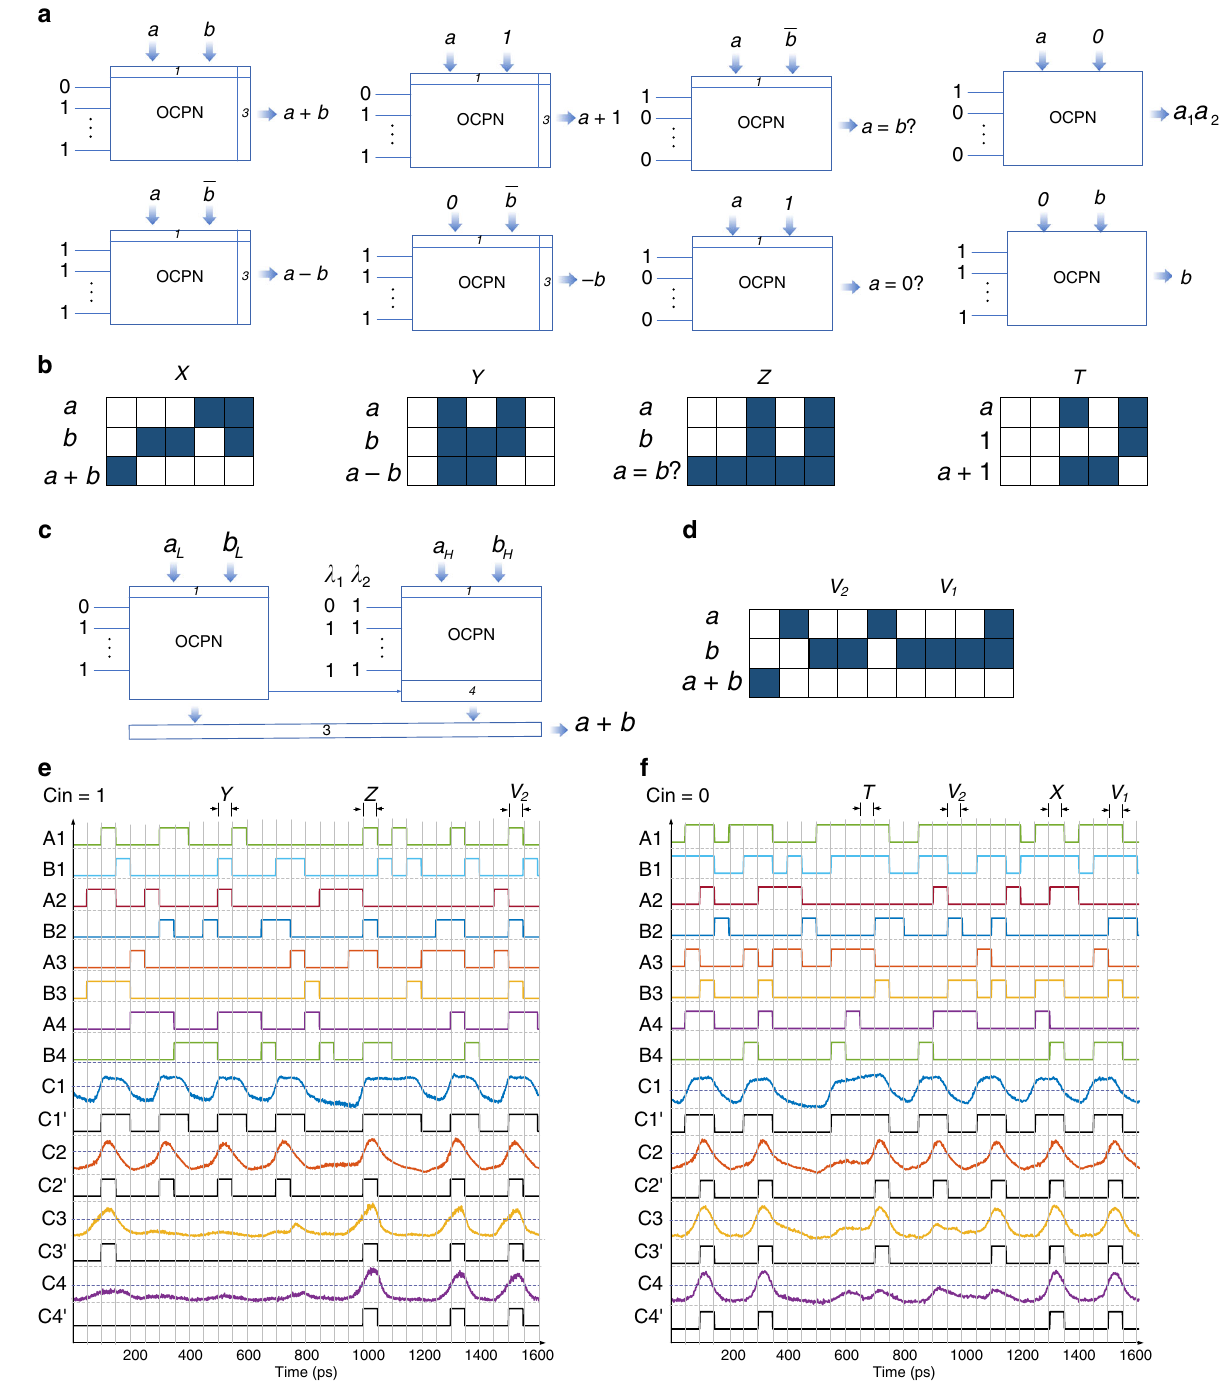
Fig. 3 Experimental results. a The functions that the proposed EPALU can achieve, including addition, subtraction, increment, decrement, compare and bit operation at different input combinations. Cell 1 represents the PGU. Cell 3 represents the SGU. b The testing result of the function realizations by the EPALU. The fi rst two rows are the inputs and the third row is the result. The blue cell means logic 1 and the white cell represents logic 0. The X, Y, Z, T correspond to the time slots in ( e ) and ( f ). c Assisted by the WDM, we could obtain results at different input states. As a result, a larger bit size EPALU can be achieved and an 8-bit case is presented. Cell 4 represents the MUXU. d One example of the WDM-based 8-bit addition based on the testing result is shown here. V corresponds to the time slot in ( e ) and ( f ). e The waveforms of the output carry signals with inputs of pseudorandom NRZ signals injected and Cin equals 1. The operation speed is 20 Gb/s with the operating wavelength of ~1540 nm. f The waveforms of the output carry signals with inputs of pseudorandom NRZ signals injected and Cin equals 0. The operation speed is 20 Gb/s with the operating wavelength of ~1565 nm.